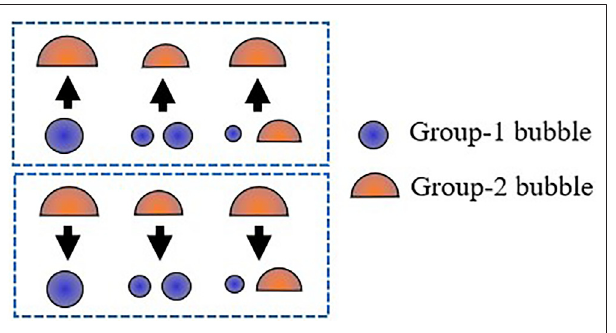
FIGURE 2 | Illustration of the intergroup transfer between group-1 and group-2